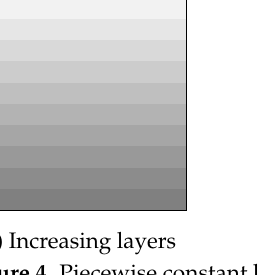
Figure 4. Piecewise constant layer profiles for the wave speed c ( x ) . For the darkest shade c ( x ) = 1, while for the lightest shade c ( x ) = ρ , with ρ being the contrast